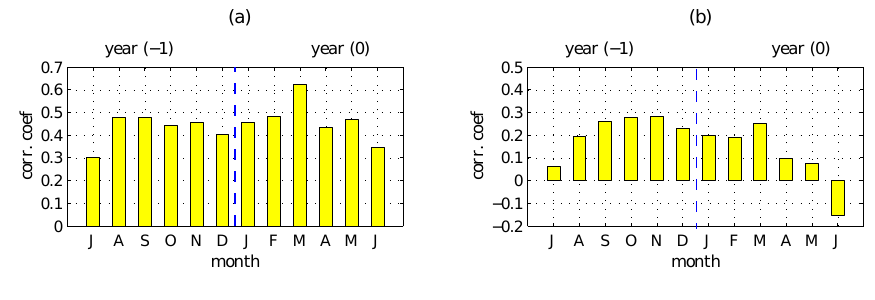
Fig. 4. Lag correlation coefficients over the period of 1968–1998 between July– September rainfall in the Sahel and the previous monthly values (July − 1 to June 0) of a deep soil wetness in- dex covering the area 5N–12N/15W– 15E, (a) rainfall index computed using NCEP/NCAR outputs; (b) rainfall in- dex computed using Hulme